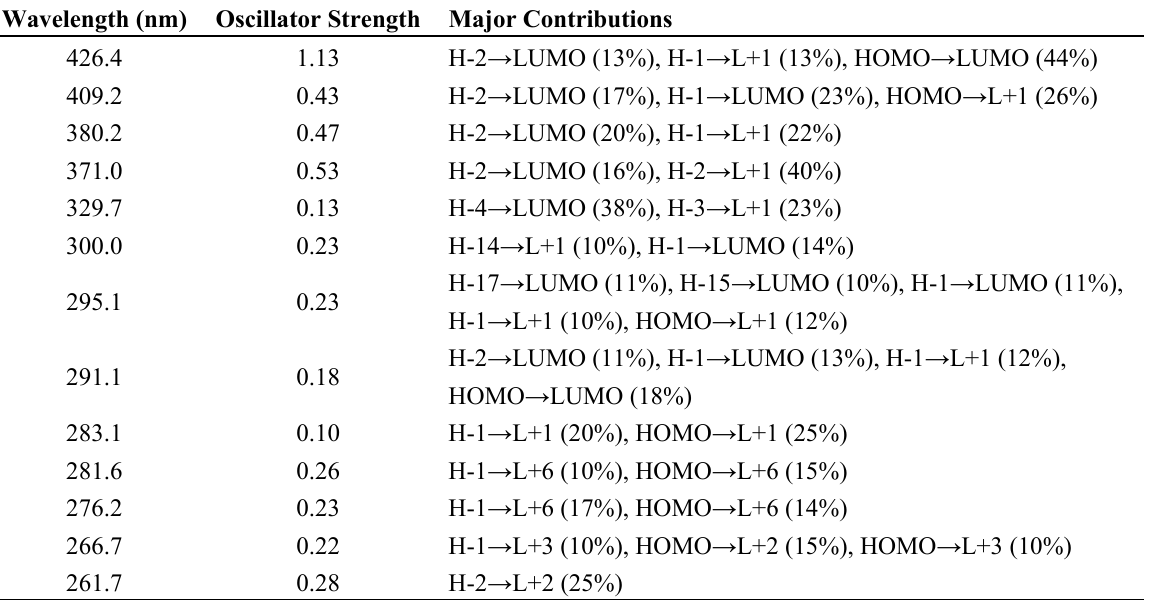
Table 3. Electronic excitations for OIC2MS with oscillator strengths (>0.1) and major contributions (above